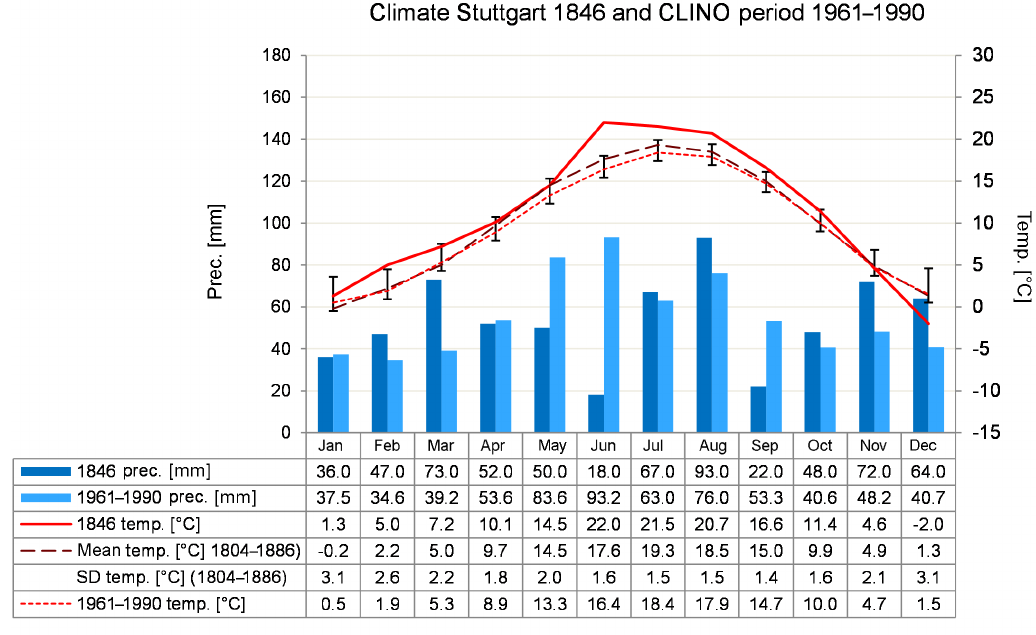
Figure 9. Temperature and precipitation for Stuttgart (1846).